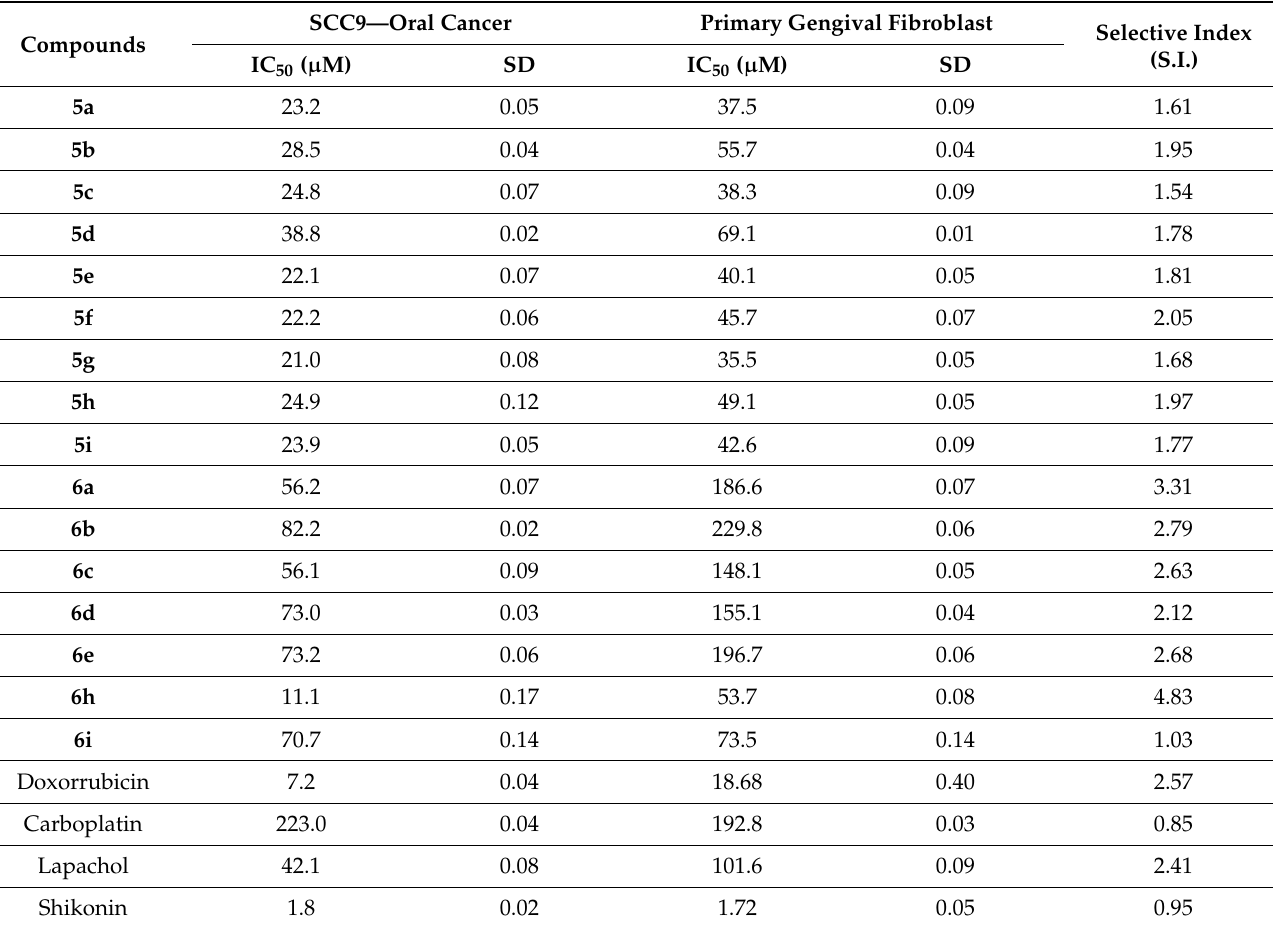
Table 1. Determination of IC 50 and selectivity index of Mannich adducts from naphthoquinones. SCC- 9 (OSCC cells) and normal human gingival fibroblasts were treated with the indicated compounds for 48 h and cell viability was determined as indicated in materials and methods. Shown from left to right: compound nomenclature, SCC-9 tumor or normal fibroblast, IC 50 ( µ M), SD and selectivity index (IS) from at least 3 independent experiments. IS = IC 50 of the compound in cells of normal oral fibroblasts/IC 50 of the same compound for oral cancer lineage SCC-9. SD = standard deviation. Most selective compound were gray shaded.